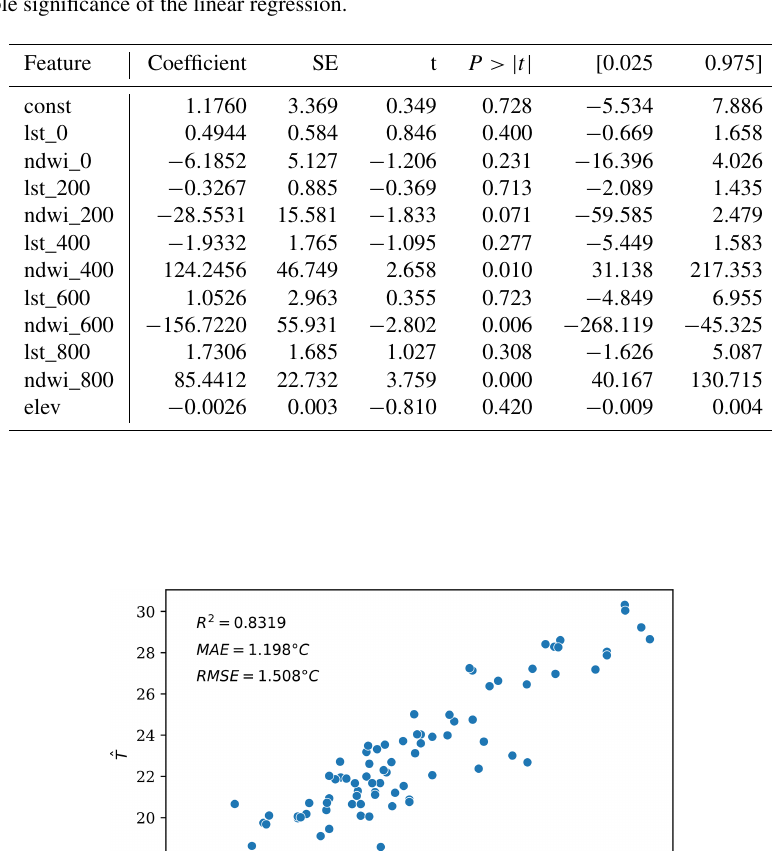
Table B1. F test of variable significance of the linear regression.